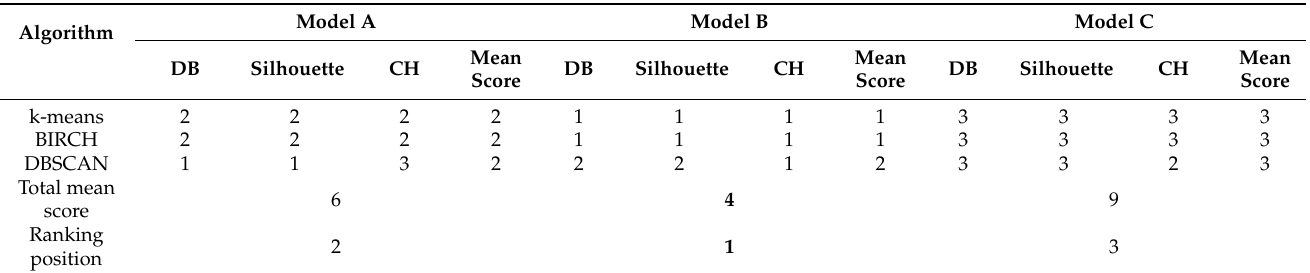
Table 9. Final score ranking based on the